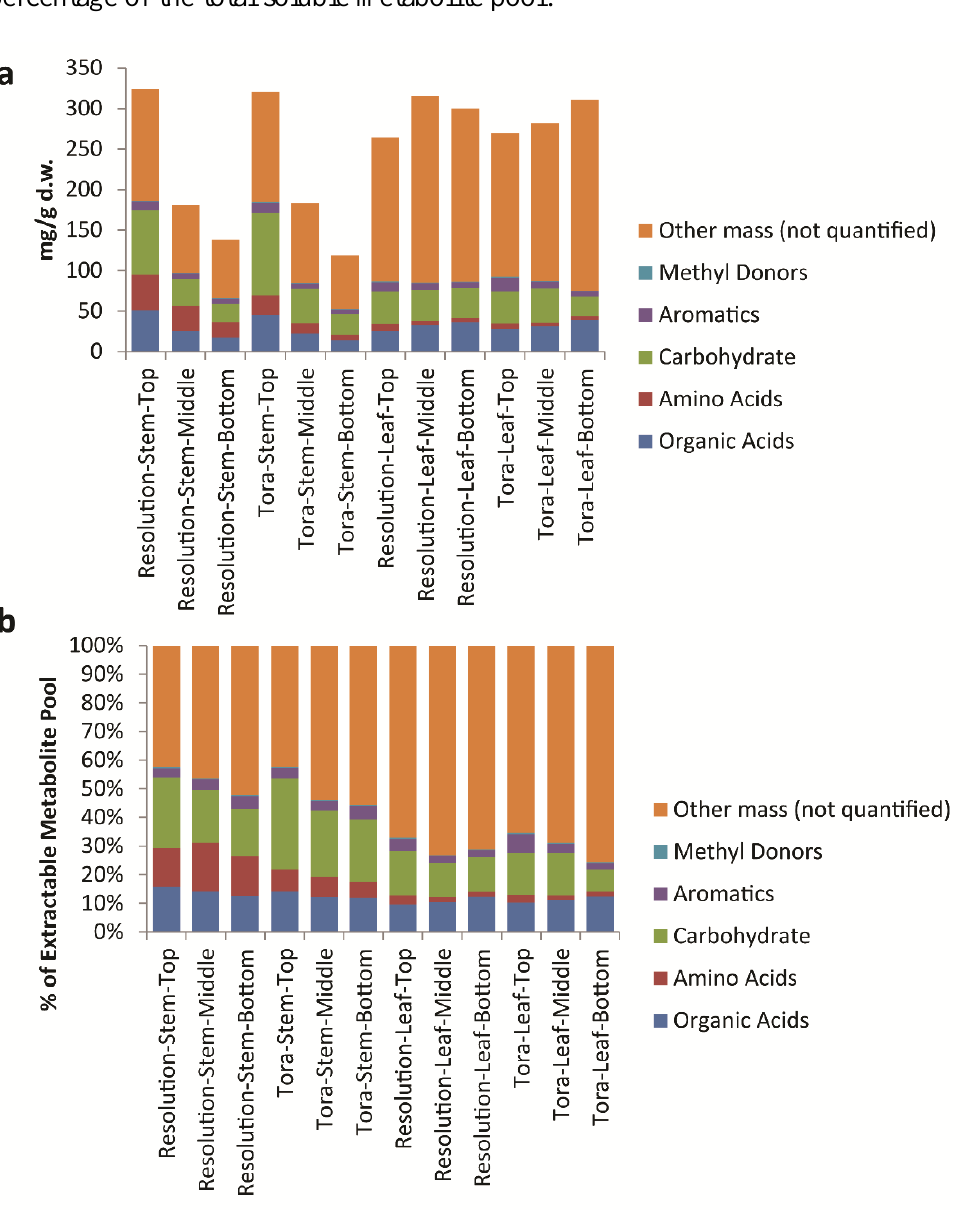
Figure 9. Calculated levels of compound classes via Chenomx quantification of metabolites as measured by 1D 1 H-NMR. ( a ) Class levels expressed as mg/g dry weight; ( b ) expressed as a percentage of the total soluble metabolite